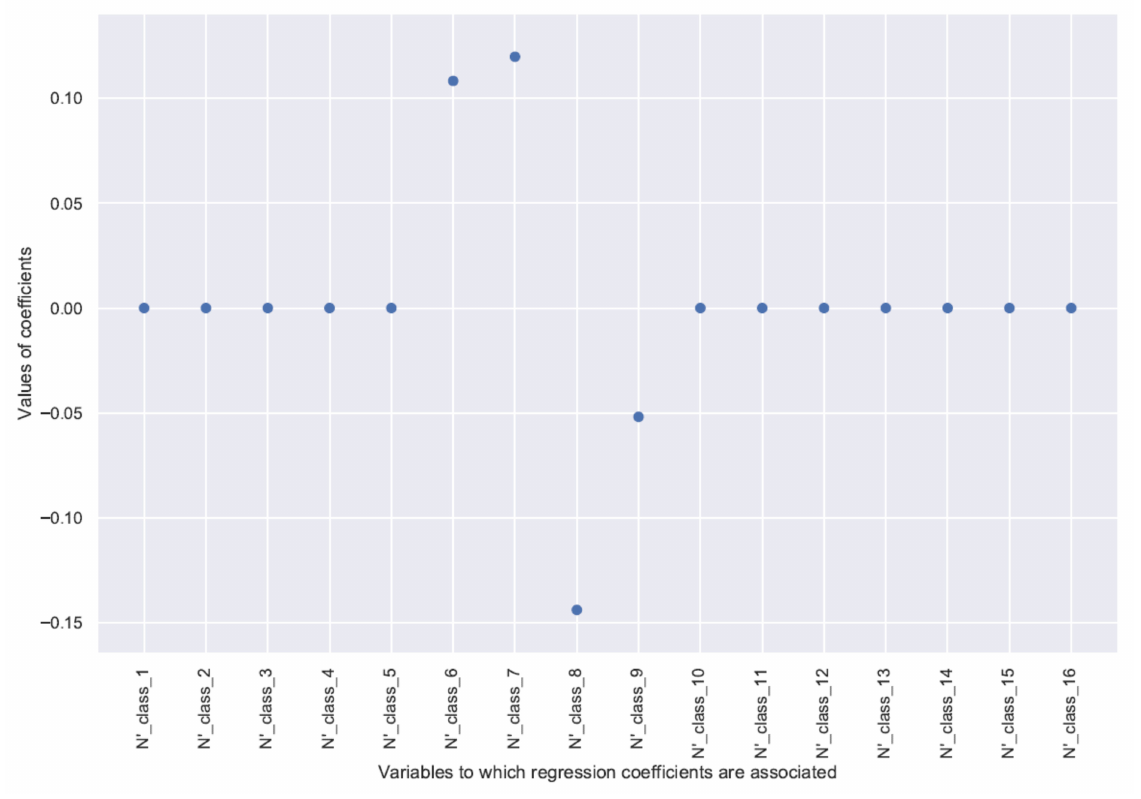
Figure 5. Regression coefficients for the model of diameter class 8, associated with transformed features N (cid:48) d